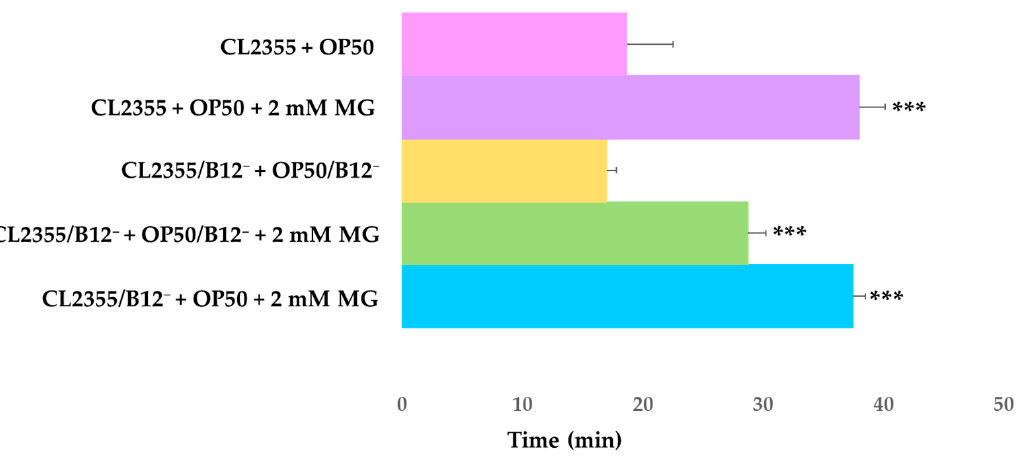
Figure 9. Serotonin sensitivity assay for L4 CL2355 and CL2355/B12 − worms treated with mogrosides. Worms were synchronously hatched and raised on NGM plates containing either OP50 or OP50/B12 − with or without 2 mM mogrosides at 16 °C for 4–5 days (approximate late L3 stage). Then switched to 22 °C for 24 h until the worms reached the L4 stage. L4 worms were scored for the time it took to complete paralysis. The standard deviations were calculated from four rep- licates for each treatment. The Student t -test was conducted to assess the statistical significance between the treatments and the CL2355 + OP50 or CL2355/B12 − + OP50/B12 − (*** p < 0.001).